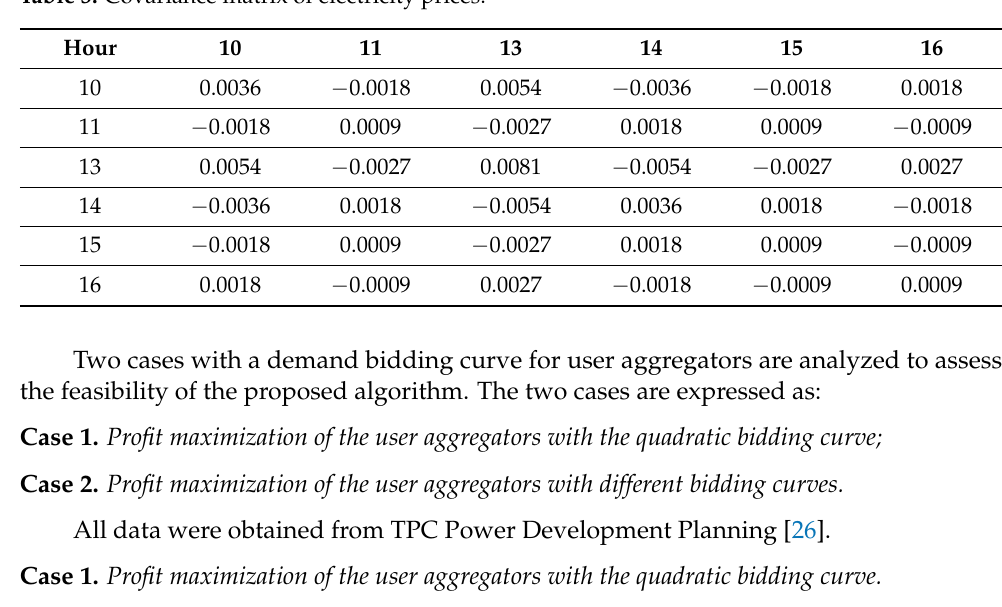
Table 3. Covariance matrix of electricity